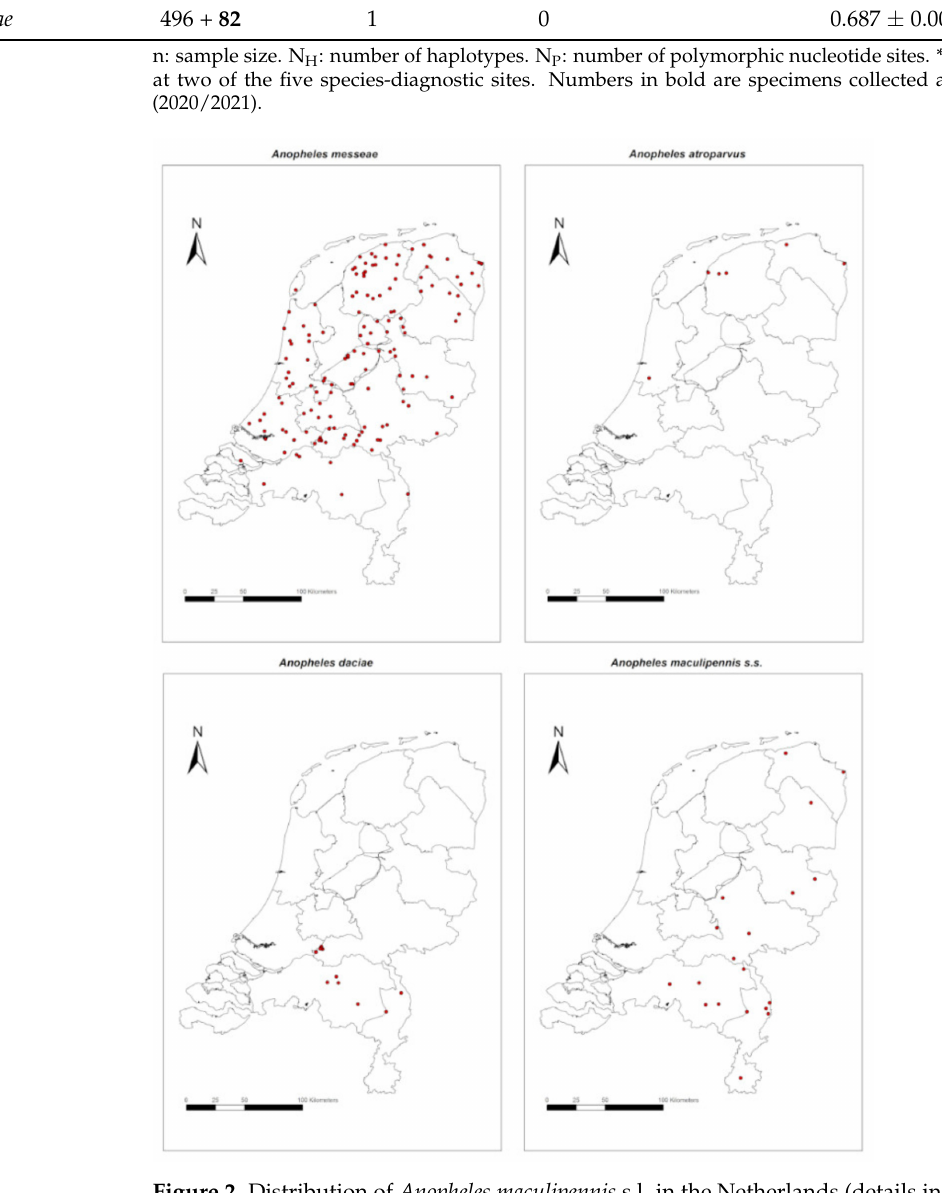
Figure 2. Distribution of Anopheles maculipennis s.l. in the Netherlands (details in Table S1) identified using DNA-based techniques: Anopheles messeae , Anopheles atroparvus , Anopheles daciae and Anopheles maculipennis sensu